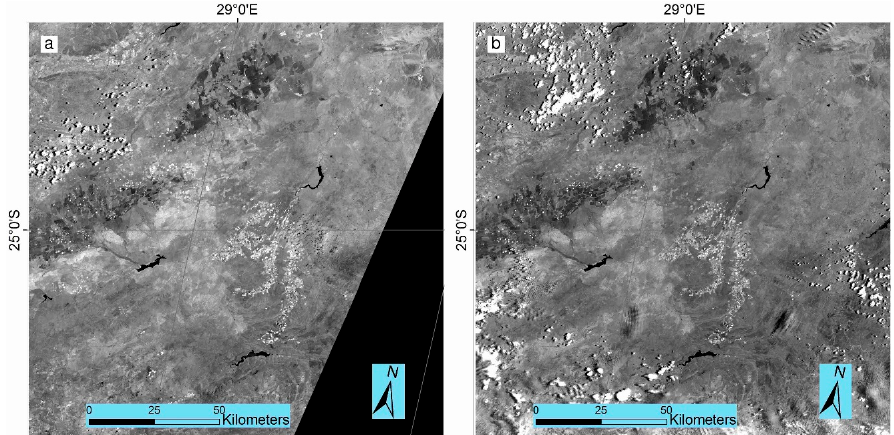
Figure 2. Limpopo Province, South Africa, test data showing ( a ) Landsat-8-L1T sensed 5 December 2015 (week 49); ( b ) Sentinel-2A L1C sensed 9 December 2015 (week 49). The NIR TOA reflectance for each image is shown, which was reprojected to 10 m global WELD tile hh20vv11.h4v3 (sinusoidal projection, 15885 × 15885 10 m pixels).